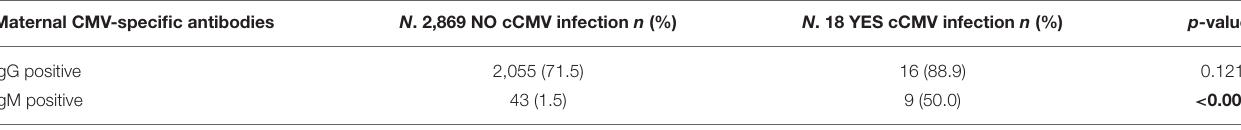
TABLE 3 | CMV immunity assessed before or during pregnancy of the study participants’ mothers. Maternal CMV-specific